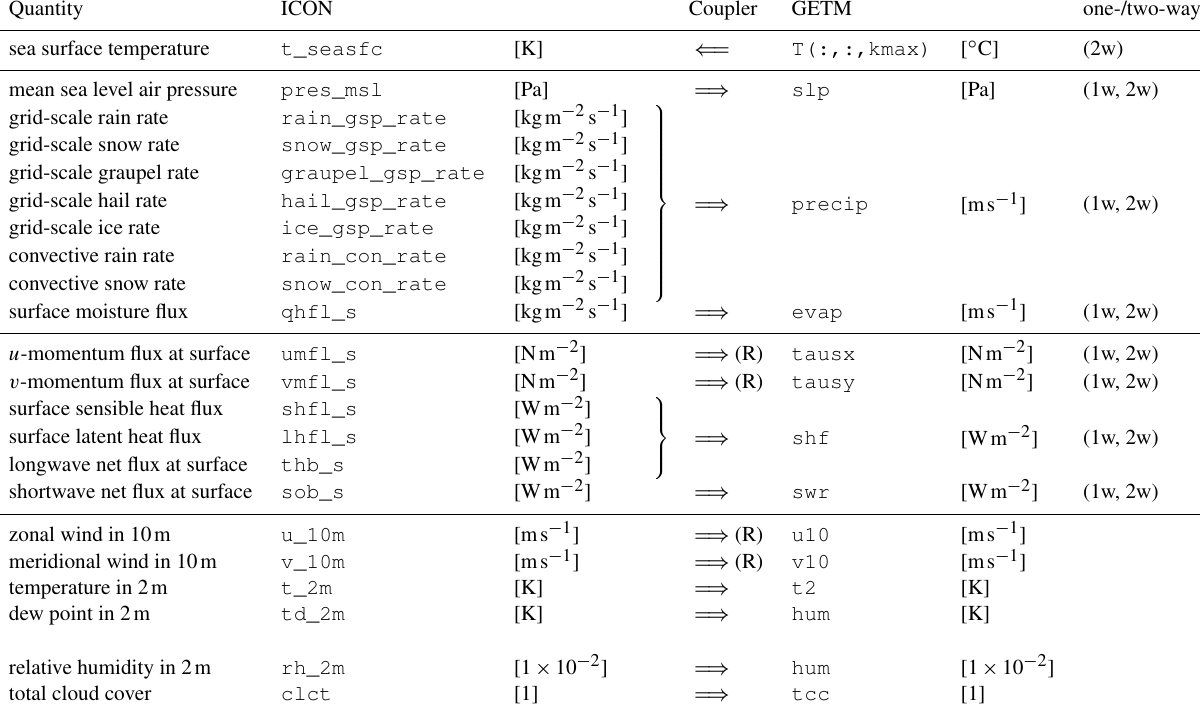
Table 1. List of quantities which can be exchanged in ICONGETM. The direction is indicated by the arrow. The units of the source and target variables are given in square brackets. Data conversion and aggregation is done automatically in the coupler. precip and evap are obtained by division with the reference density of freshwater. The corresponding contributions to precipitation from graupel, hail and ice are only considered for the coupling if they are activated in ICON. Wind data need to be rotated (R) to the local coordinate system in GETM. The exchanged humidity quantity (dew point or relative humidity) is correctly identified by the name attribute of the connected ESMF field. The possibility to exchange either flux data (third block) or state variables (last block) offers the comparison of different coupling strategies within the same model environment. The last column indicates which data are exchanged during the performed one- and two-way coupled simulations. The exchange of state variables is not applied in the simulations presented in Sect.